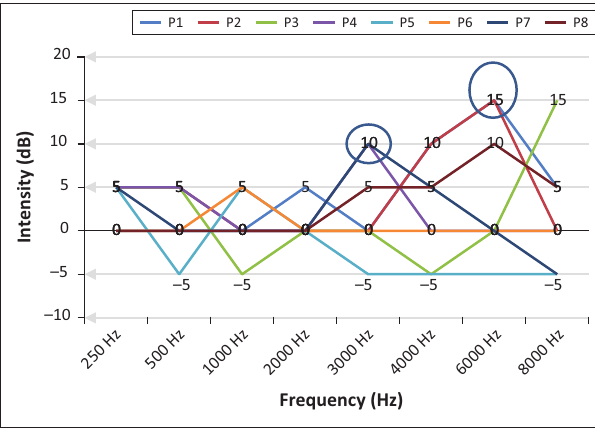
FIGURE 3: Configuration of participants’